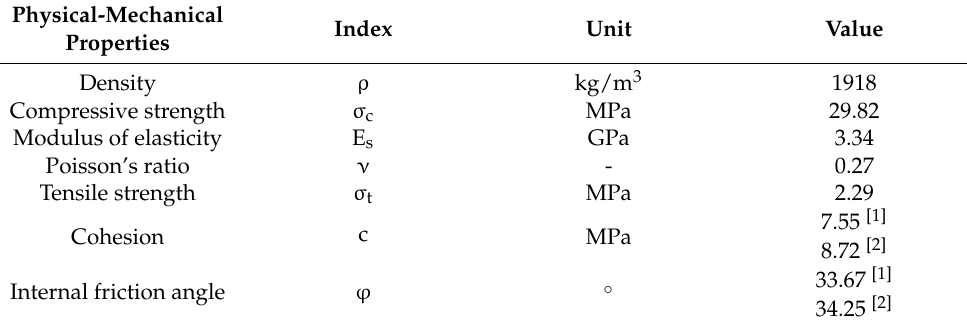
Table 1. Physical-mechanical properties of